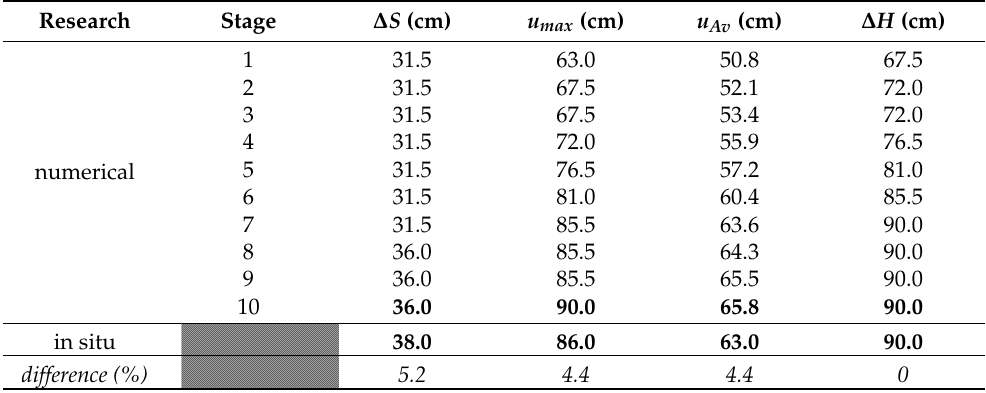
Figure 26. Stages of the numerical simulation of the impact of water saturation of the rocks beneath the floor of roadway D-2 on the magnitude of the floor heave, and with various geomechanical properties: gray color—dry rocks, green—rocks after 3 h of soaking with water, yellow—rocks after 6 h of soaking, purple—rocks after 12 h of soaking, dark blue—rocks after 24 h of soaking. Table 8. Comparison of the convergence results from numerical model of roadway F-33 with the in situ measurements on the 415th meter of the roadway. Table 6. Comparison of the convergence results from numerical model of roadway D-2 with the in situ measurements of the 614th meter of the